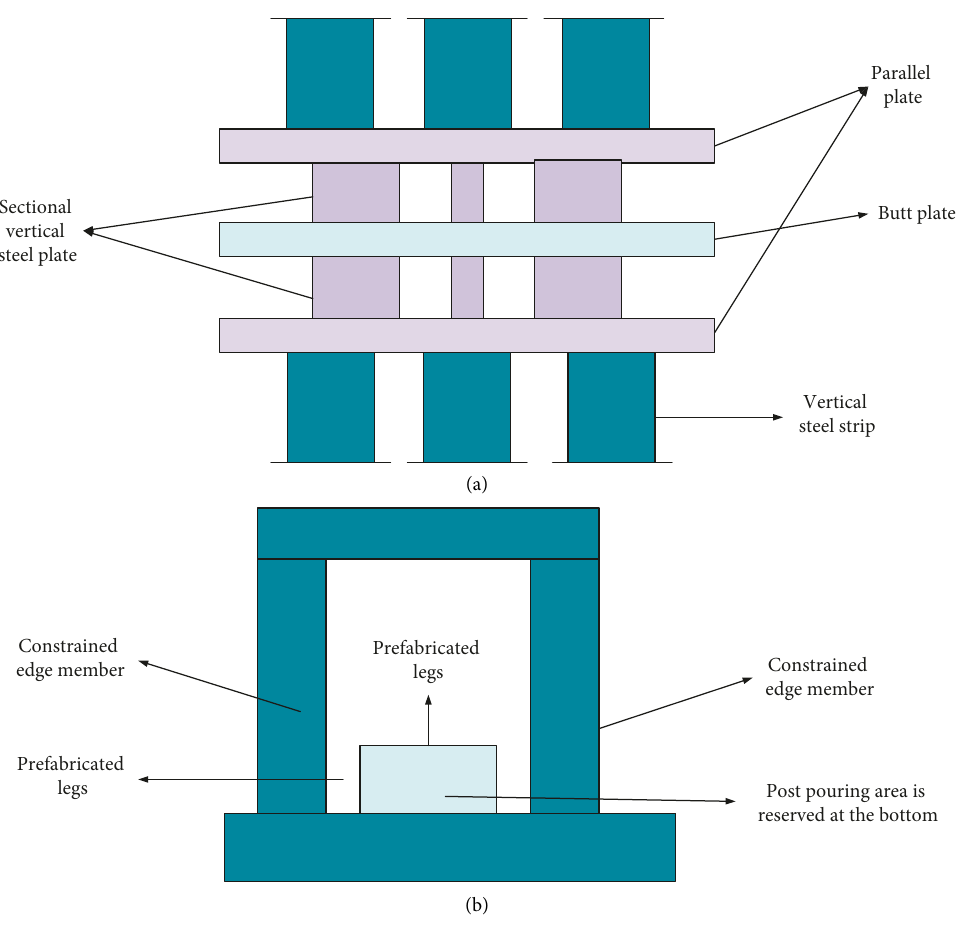
Figure 1: Shear wall horizontal joint structure: (a) shear wall of steel plate strip concrete and (b) prefabricated shear wall with reserved postcast area at the